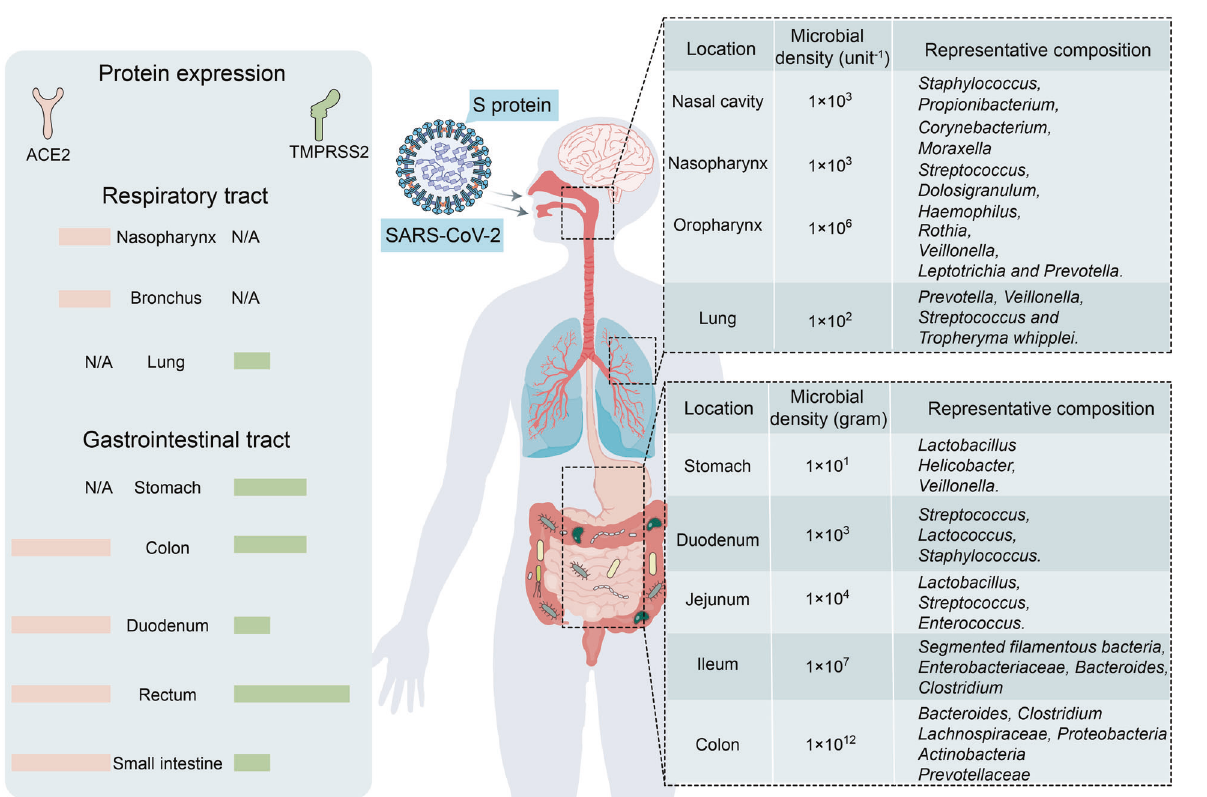
Fig. 2 Primary habitats of human microbiota: respiratory and gastrointestinal tracts as SARS-CoV-2 infection targets. SARS-CoV-2 receptors ACE2 and TMPRSS2 are expressed mainly in respiratory and gastrointestinal tracts which provide many suitable habitats for microorganisms. The right side of the fi gure lists representative bacterial populations in different parts of the respiratory and gastrointestinal